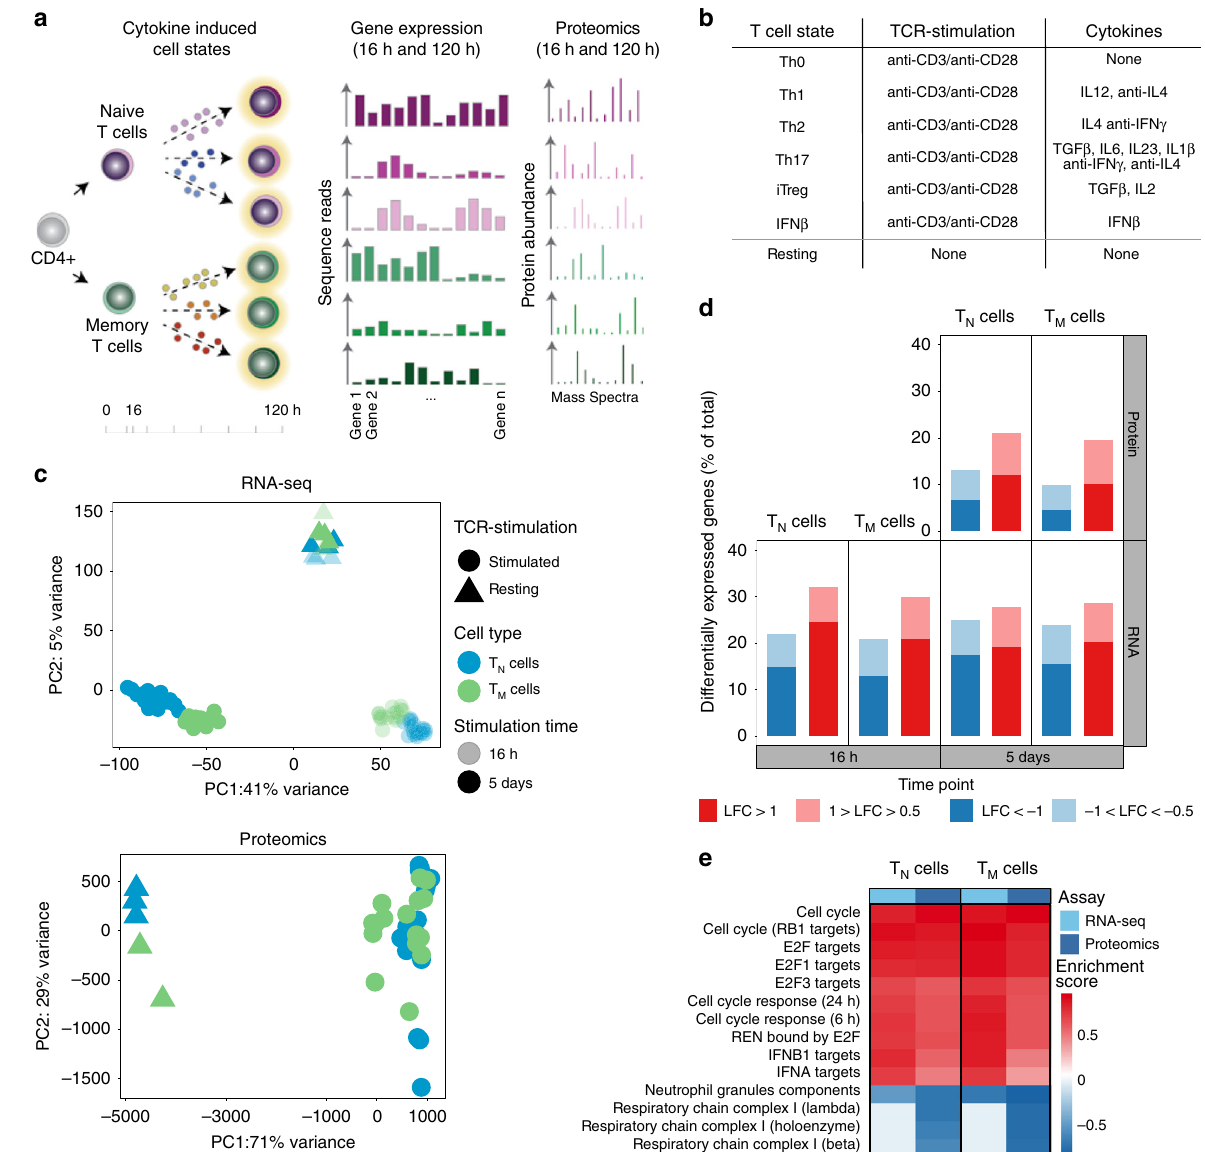
Fig. 1 TCR/CD28-activation induces cell type speci fi c gene expression programs in CD4 + T cells. a Overview of the experimental design. b List of cytokine conditions. c PCA plots from the whole transcriptome (upper panel) and proteome (lower panel) of T N and T M cells. Different colors correspond to cell types and different shades to stimulation time points. PCA plots were derived using 47 naive and 47 memory T cell samples for RNAseq and 21 naive and 19 memory T cell samples for proteomics. d Gene expression changes at the RNA and protein levels by comparing TCR/CD28-activated (Th0) cells to resting cells. Up-regulated genes are in red and down-regulated genes are in blue. Different shades indicate different fold-change thresholds. e A selection of signi fi cantly enriched pathways (with enrichment scores > 0.7) from genes and proteins differentially expressed after 5 days of activation using the 1D enrichment method. Source data are provided as a Source Data fi